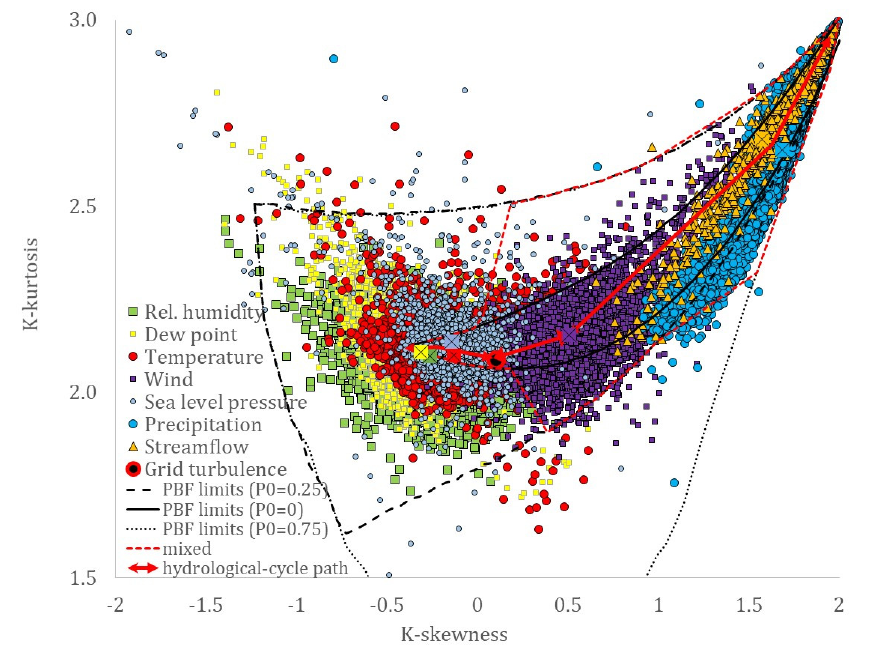
Figure 11. K-skewness vs. K-kurtosis, estimated through the hyper-central K-moments, for the key hydrological-cycle and the grid-turbulence processes, and the empirically calculated limits of the mixed Pareto-Burr-Feller distribution for probabilities of zero values at 25% and 75%. The mean values of the K-skewness and K-kurtosis for each process are depicted by the square markers with the x-symbol inside.